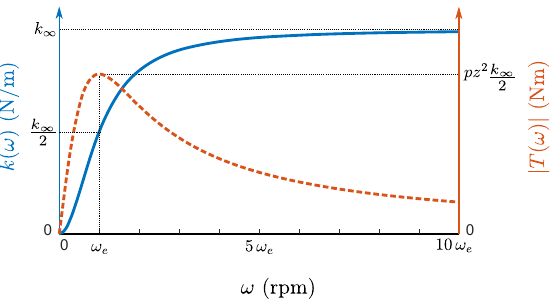
Figure 2. Evolution of the electrodynamic stiffness k (solid line) and braking torque T (dashed line) with the spin speed ω